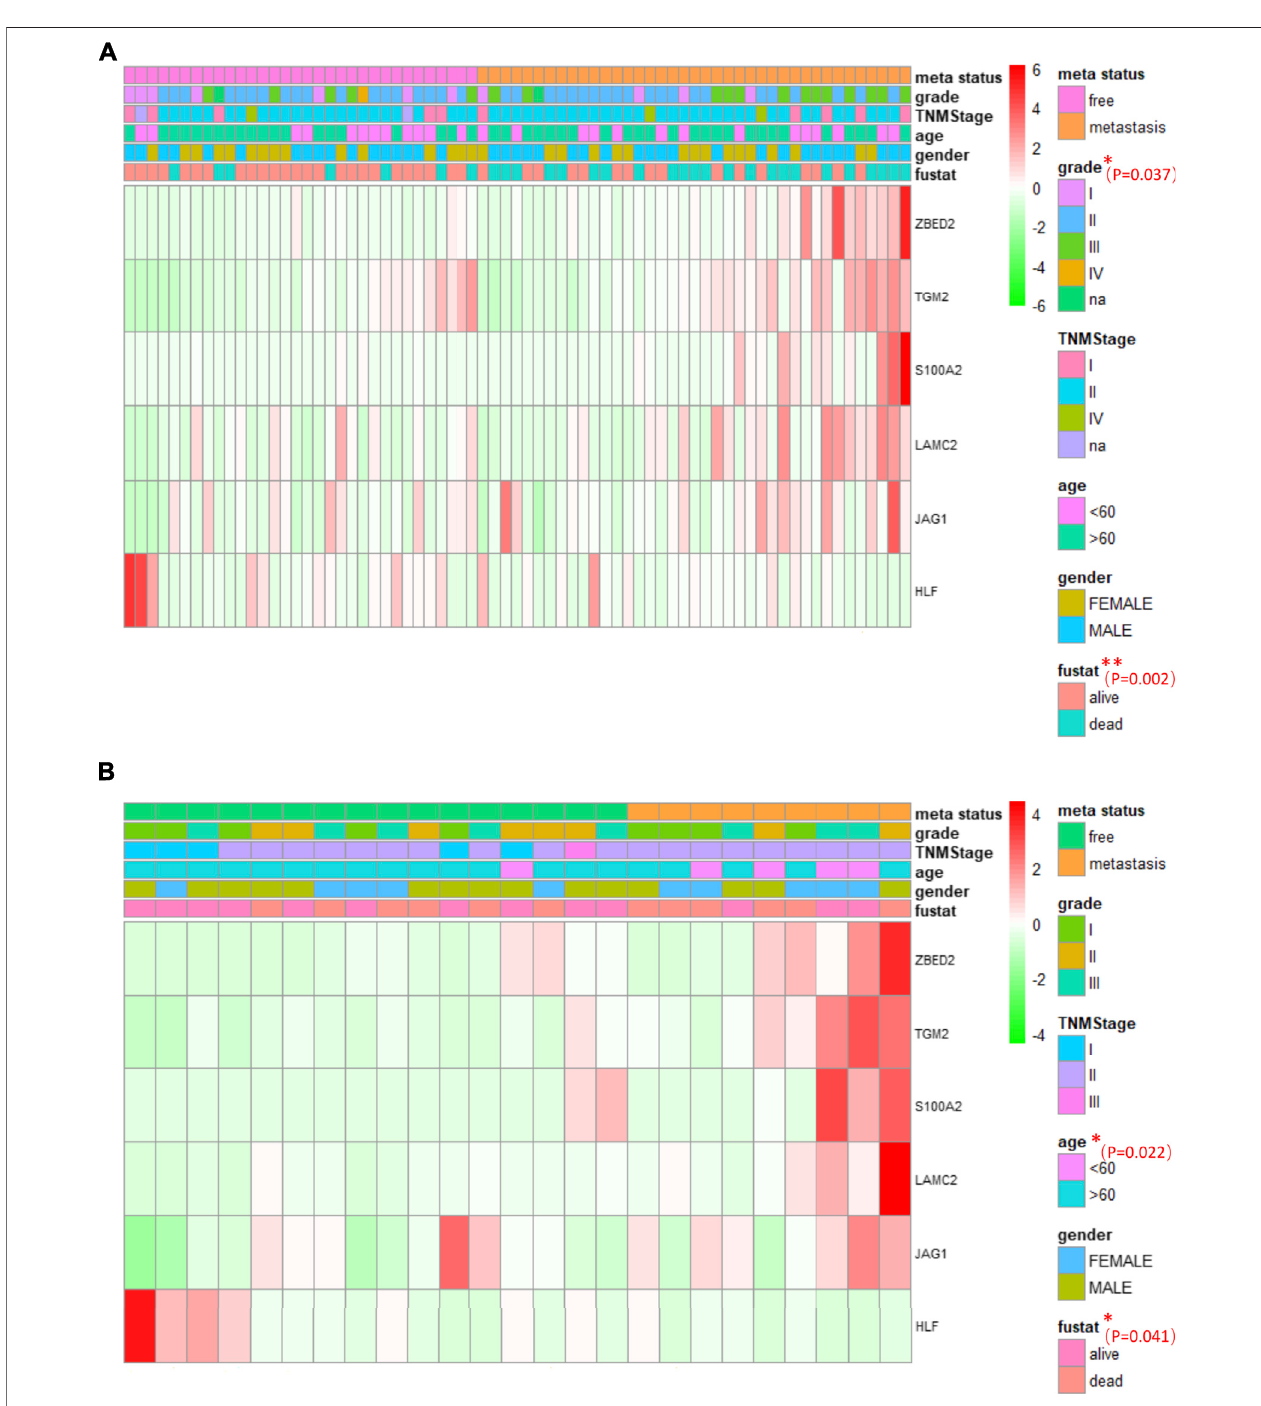
FIGURE6 | The association between pancreatic cancer metastasis and patient characteristics, and heatmaps ofsix genesin pancreatic cancer metastasis (A, B) The heat maps of six EMT related genes in the free and metastatic groups in the train set (A) and test set (B) . The distribution of patient characteristics was compared between the free and metastatic groups. * p < 0.05 and ** p < 0.01.